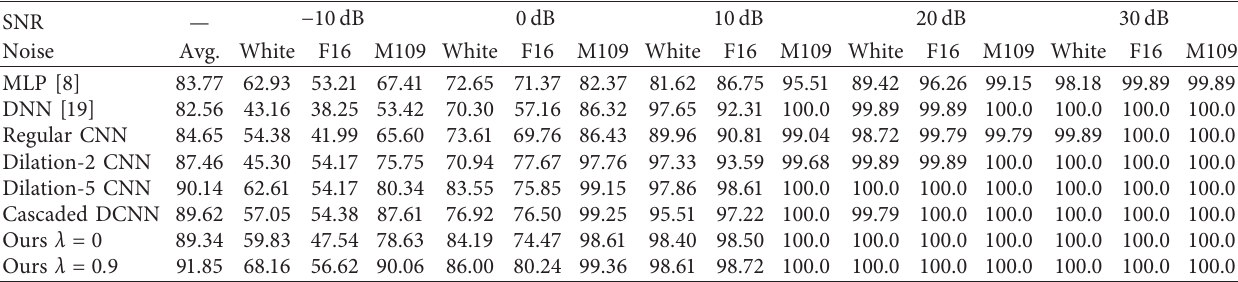
Table 2: Localization accuracy (%) of different approaches in additively noisy environments. SNR